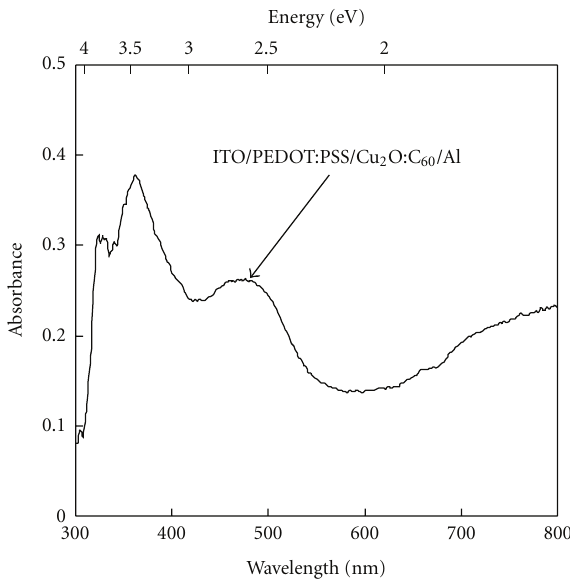
Figure 10: Optical absorption of Cu 2 O:C 60 bulk heterojunction solar